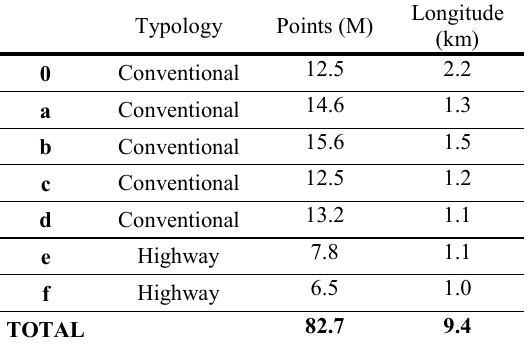
Table 1. Characteristics of point clouds used as case